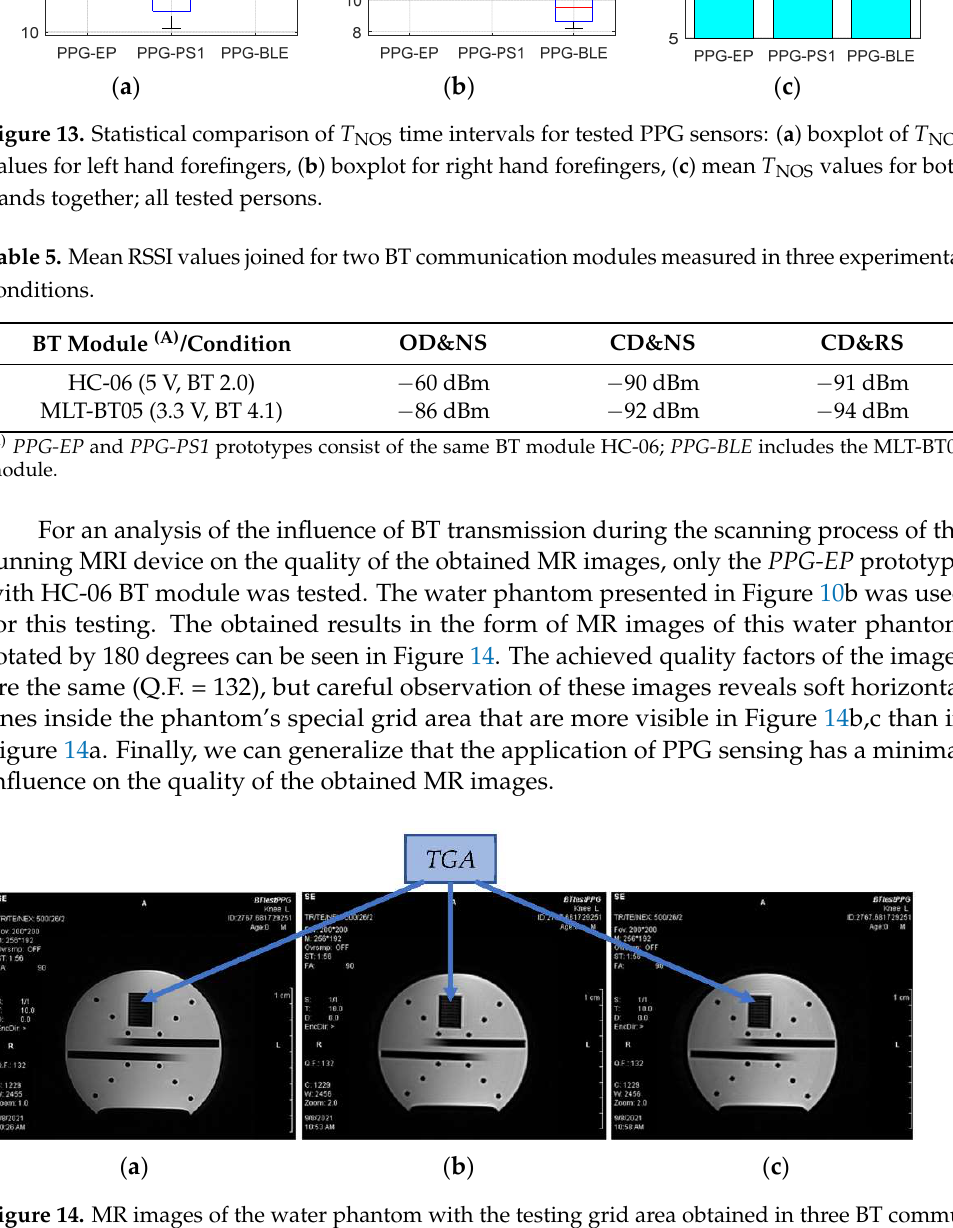
munication conditions of the PPG-EP sensor with the HC-06 BT module placed in the scanning area of the MRI device: ( a ) without any BT connection, ( b ) after established connection to the control device, ( c ) during data transmission to the control master device; executed Hi-res SE-HF scan sequences with TE = 26 ms, TR = 500 ms, and sagittal orientation.